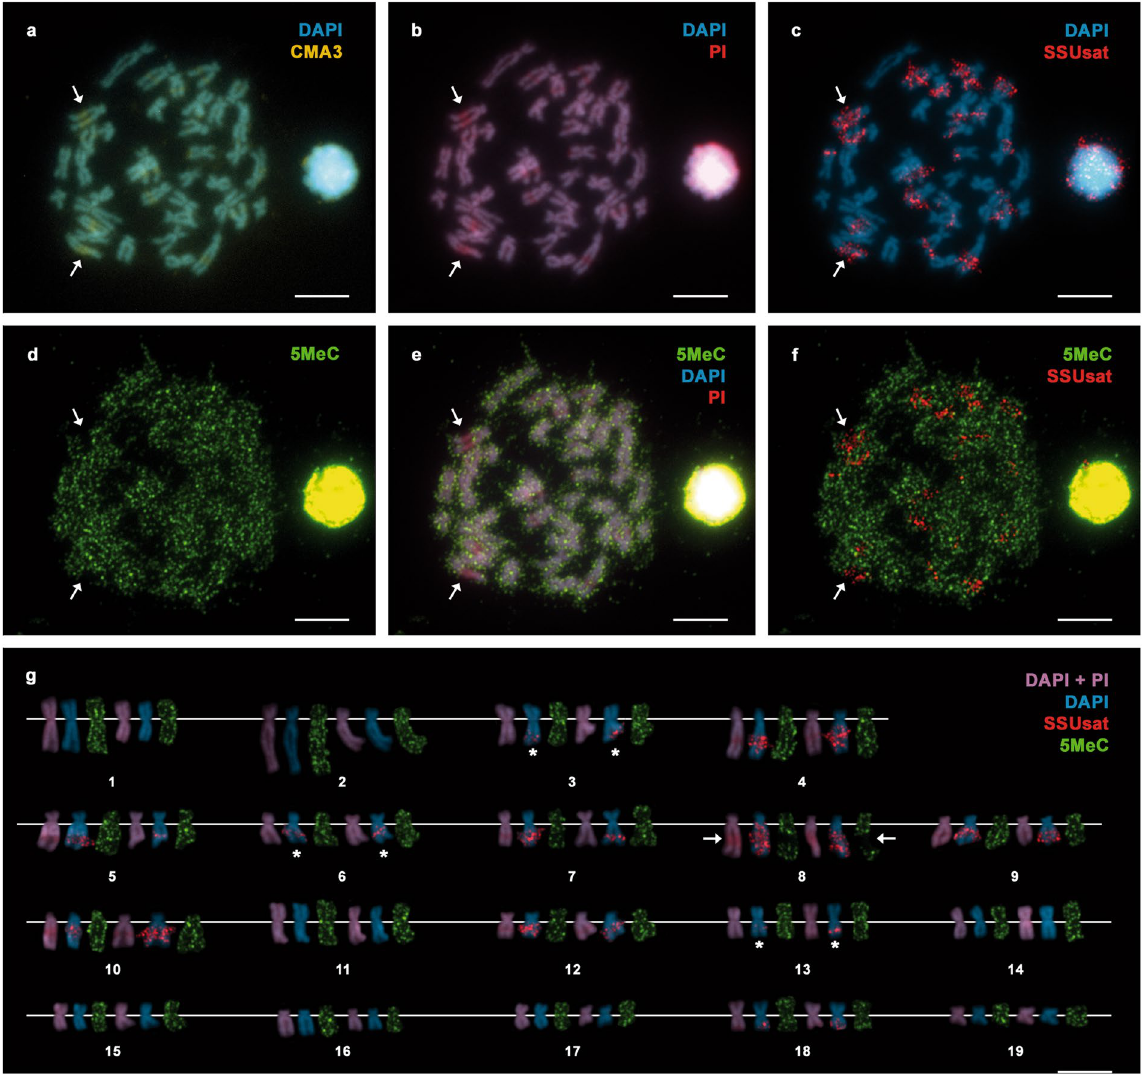
Figure 6. Chromosomal location of G + C-rich bands, SSUsat and methylated regions in Spisula subtruncata . DAPI/CMA ( a ) followed by DAPI/PI staining ( b ) and FISH using the SSUsat probe ( c ) on the same metaphase plate and the corresponding karyotype ( g ) show that SSUsat signals mainly co-locate with the CMA positive, DAPI negative, G + C-rich intercalary heterochromatic regions on chromosome pairs 4, 5, 7, 8, 9, 10 and 12 and with the subterminal G + C-rich heterochromatin associated with the NOR on chromosome pair 18. Additional intercalary SSUsat signals are also present in regions not showing conspicuous CMA + /DAPI- staining in the long arms of chromosome pairs 3, 6 and 13 (asterisks in g ). Immunolocalization of 5-methylcytosine (5- MeC) in the same metaphase plate ( d – f ) and the corresponding karyotype ( g ) mainly shows a homogeneous distribution of the 5-MeC signals with two main exceptions; the absolute lack of methylation signals on the biggest, intercalary CMA + /DAPI-, G + C-rich, heterochromatic, SSUsat-bearing band on the long arm of chromosome 8 (arrows in a – g ) and the strong methylation showed by the subterminal NOR in one of the homologous chromosomes of pair 18. Scale bars, 5 μ m.